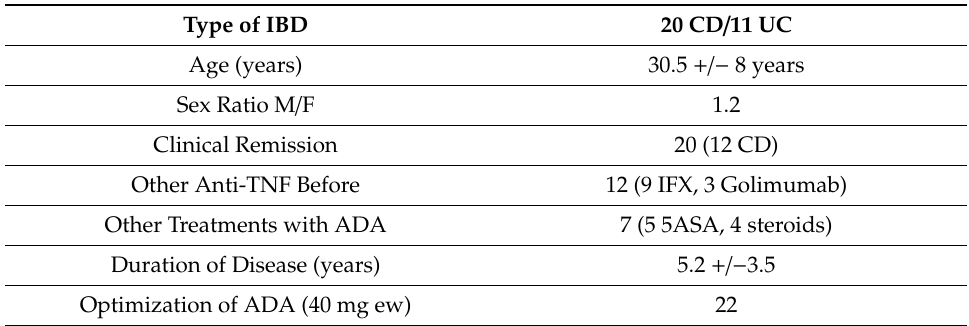
Table 1. Clinical characteristics of the first retrospective IBD cohort. IBD: Inflammatory Bowel